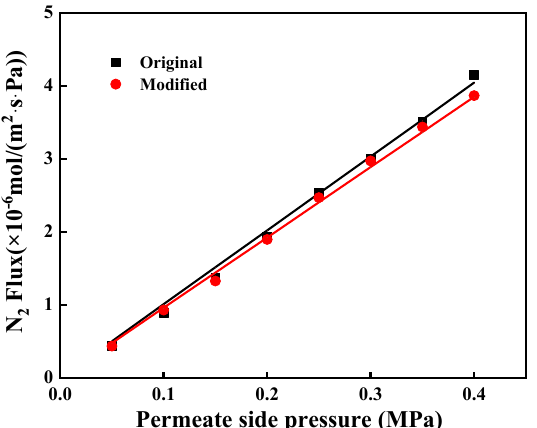
Figure 8. The N 2 flux of the ceramic membrane before and after modification.